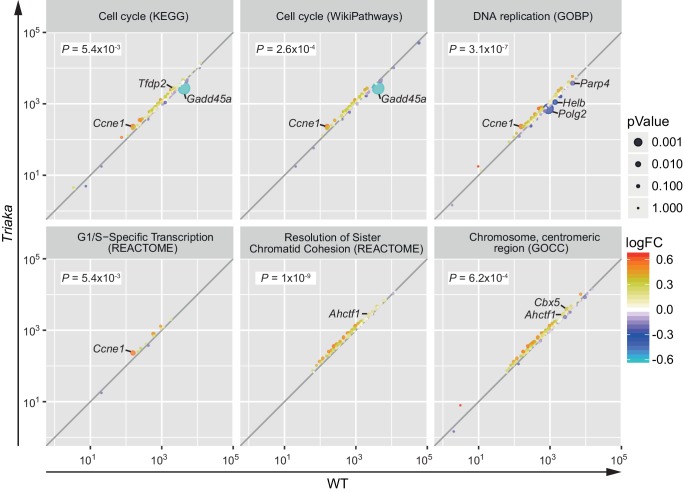
Esrp1Triaka alters the expression of genes associated with cell proliferation.RNA sequencing data were used to perform a gene set enrichment analysis using the SetRank method. LogFC plots show genes that are differently expressed in Triaka versus WT colonic intestinal epithelial cells (n = 4 donor mice per group). The color of each dot reflects the log2 fold change and the size of a dot represents the Benjamini-Hochberg adjusted p-value of a gene involved in the indicated pathways. Genes with individual significant p-values are indicated and p-value for the indicated pathways are shown.